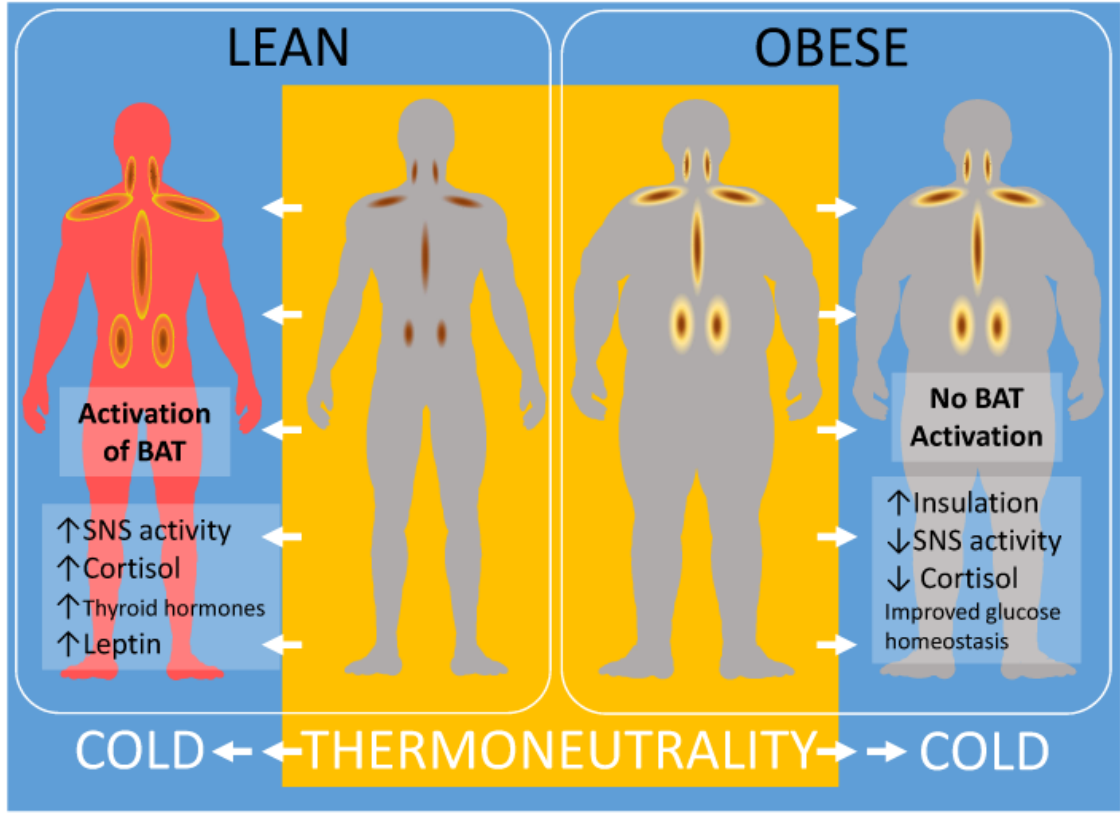
Figure 1. Summary of the impact of obesity on brown adipose tissue function and regulation in adult humans and the potential benefits of chronic cold exposure. ATGL, adipose triglyceride lipase; BAT, brown adipose tissue; FFA, free fatty acid; HSL, hormone-sensitive lipase; MGL, monoglyceride lipase; NEFA, non-esterified fatty acid; SNS, sympathetic nervous system; T, temperature; TG, triglyceride; WAT, white adipose